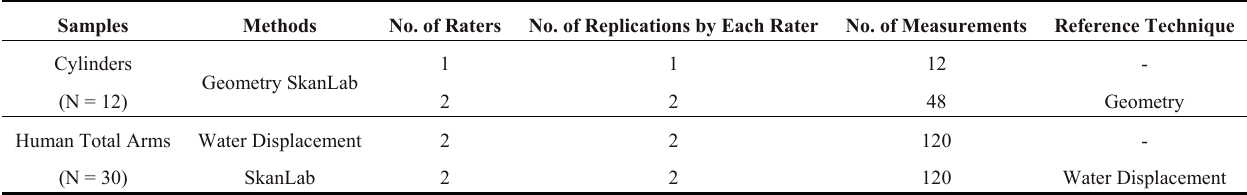
Table 1. Methods and reference technique applied for volumetric